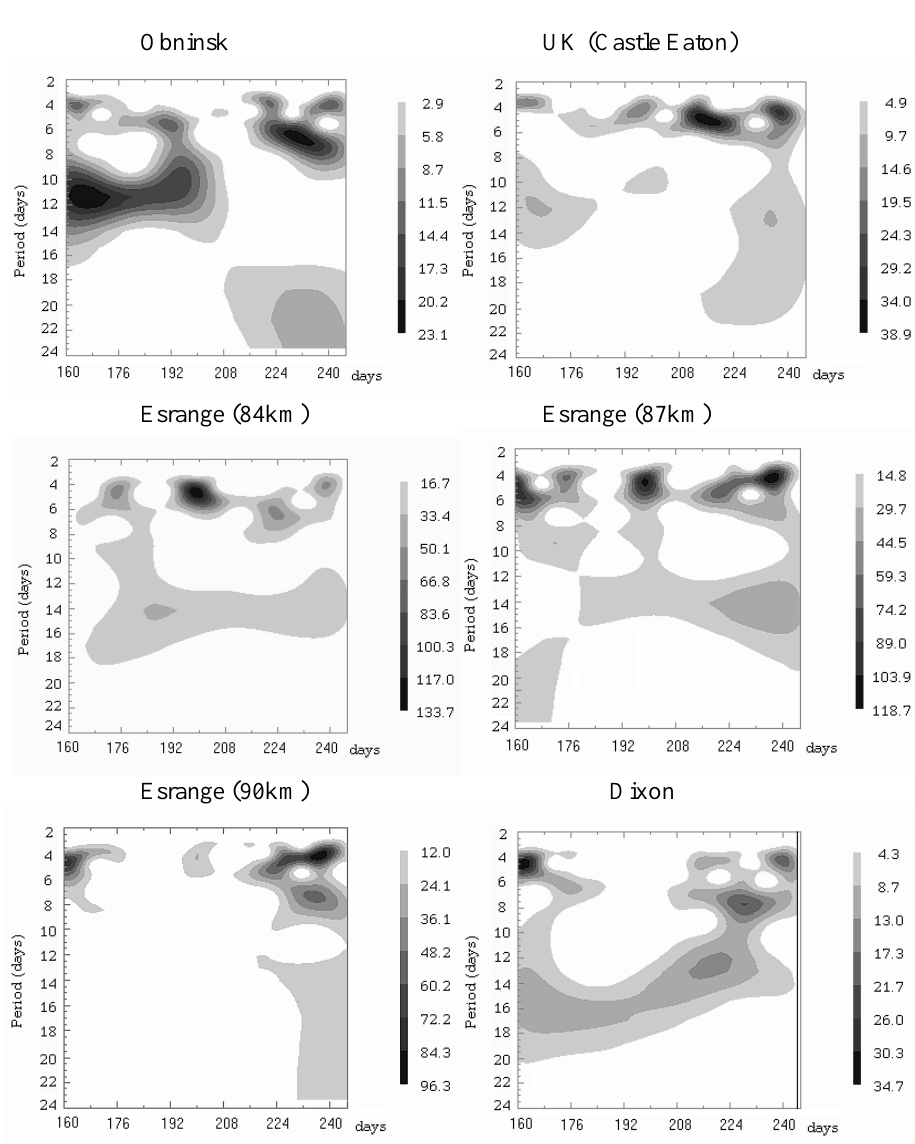
Fig. 6. S-transform spectra of day-to-day zonal wind variations. The data are low-pass filtered with a cut-off period of 72h.